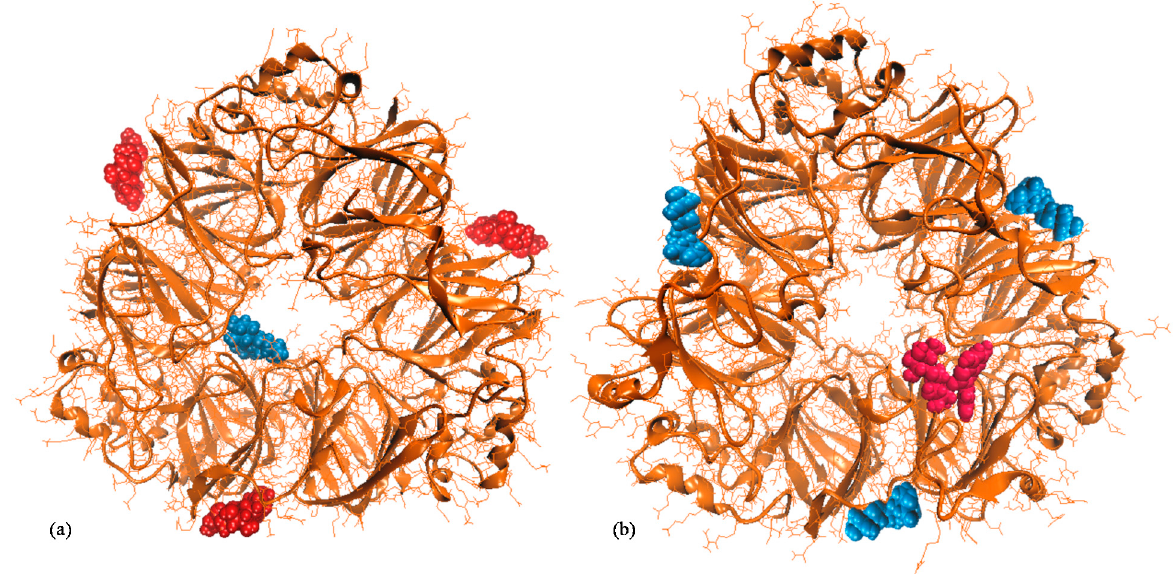
Figure 2. ( a ) Molecular models of the complexes formed between native α ’ homotrimer ( a ) and β homotrimer ( b ) of β -conglycinin (New Cartoon style) with cyanidin 3-glucoside (van de Waals style in blue) and cyanidin 3-rutinoside (van de Waals style in red).